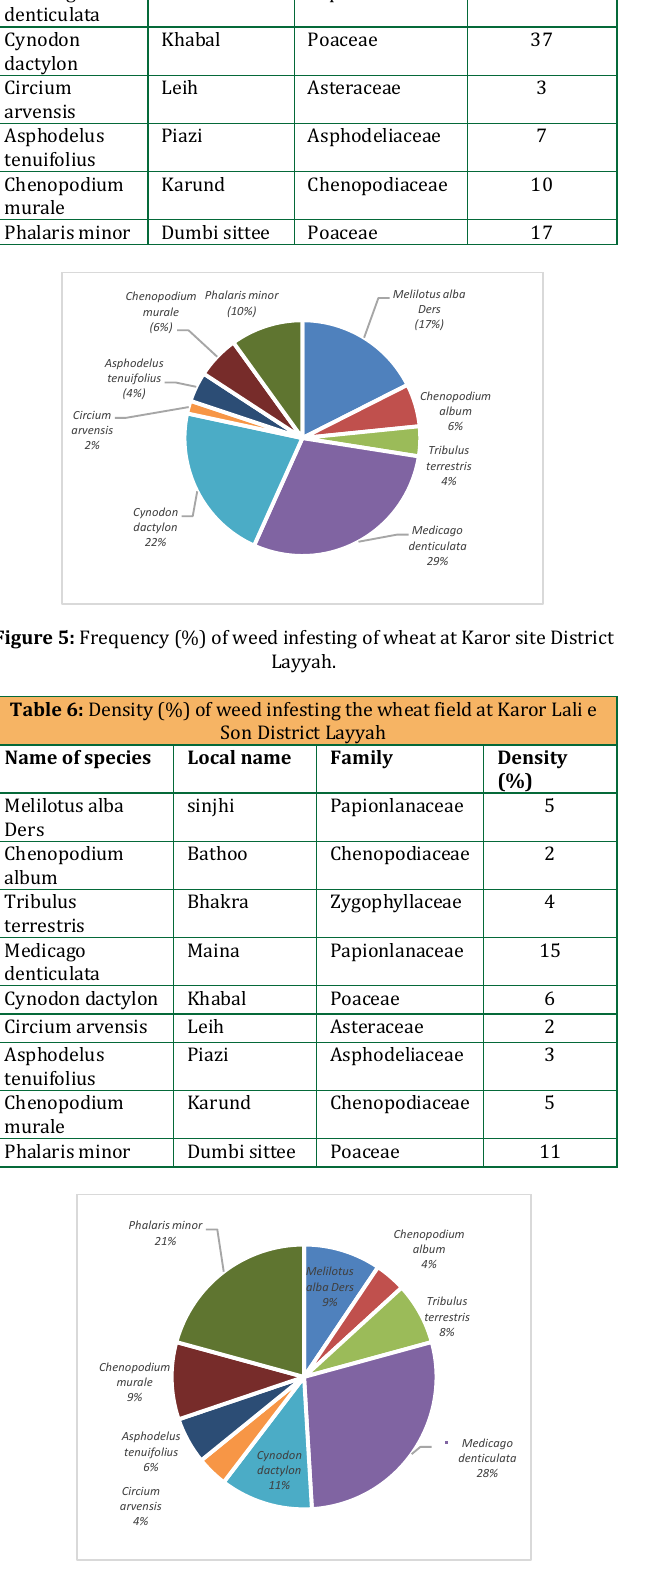
Figure 6: Density (%) of weed infesting the wheat field at Karor Lali e Son District Layyah.